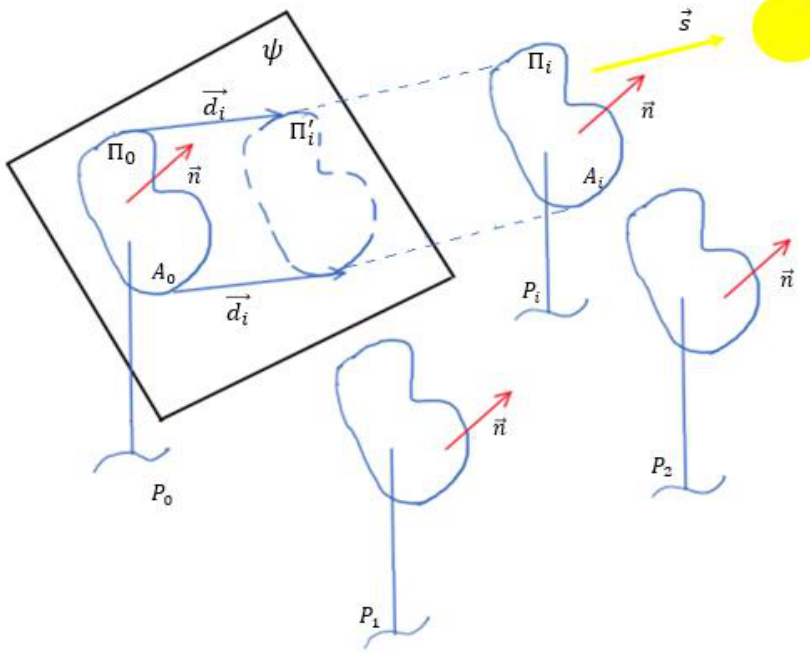
Figure 2. Astronomical and geometric magnitudes considered.